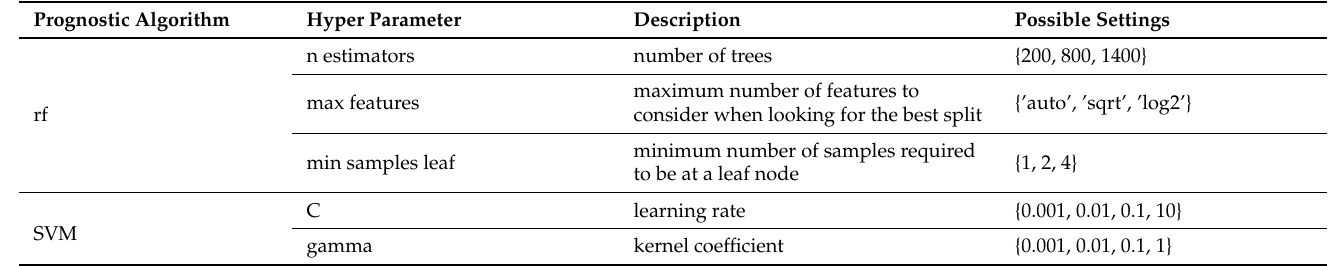
Table 3. The hyper parameters and combination of settings explored during the grid search for each of the prognostic